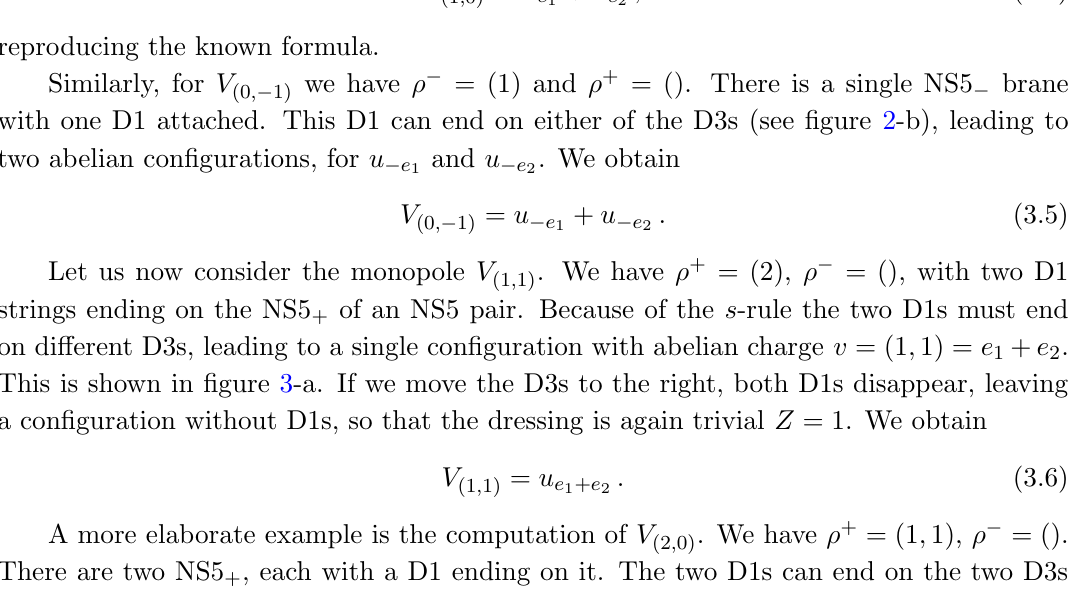
= u e + u e and b) V (1 ; 0) (0 ; (cid:0) 1) 1 2